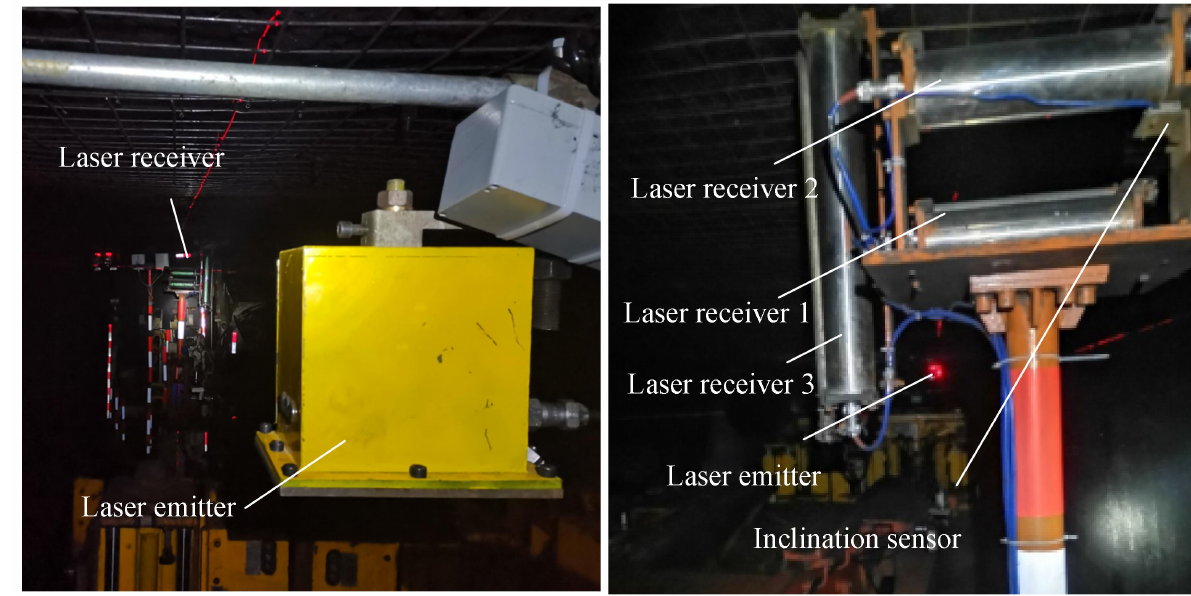
Figure 16. The industrial test